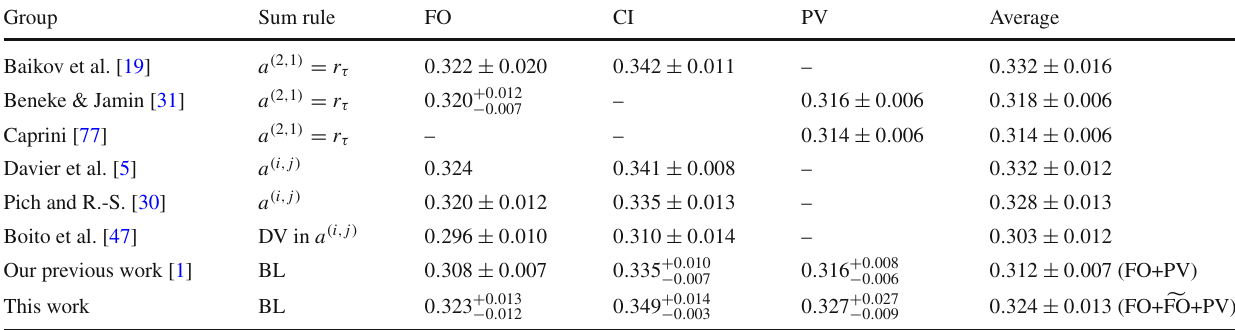
Table 4 The values of α s ( m 2 τ ) , extracted by various groups applying sum rules and various methods to the ALEPH τ -decay data. BL stands for Borel–Laplace sum rules, and DV for a Duality Violation model in sum